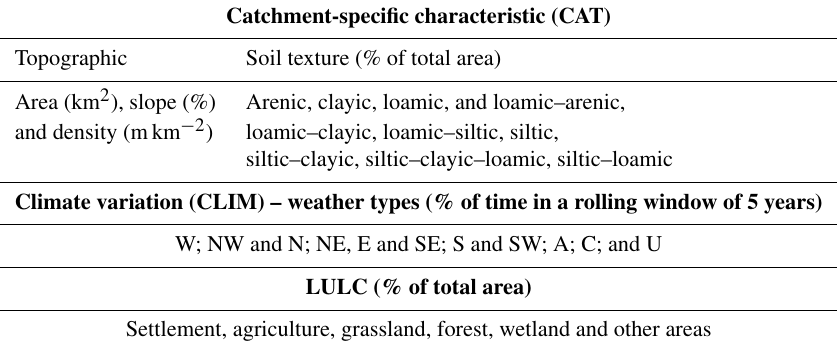
Table 1. Drivers considered for this study.